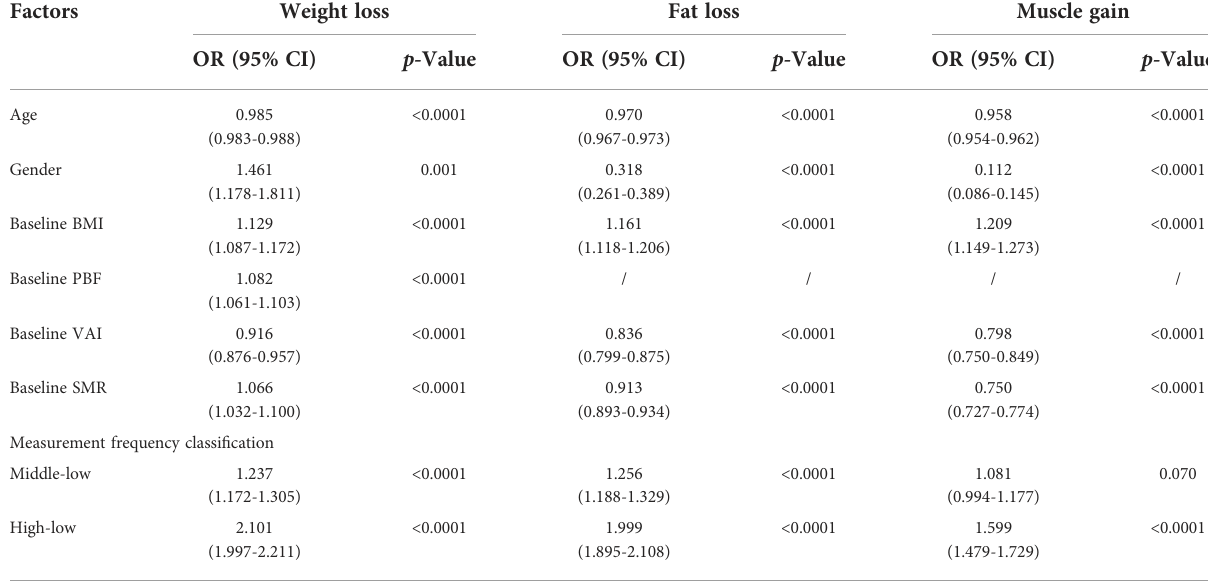
TABLE 3 Factors associated with the effective change of weight and obesity-associated body composition.